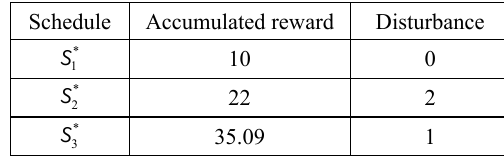
Table 5. The reward and disturbance of schedules